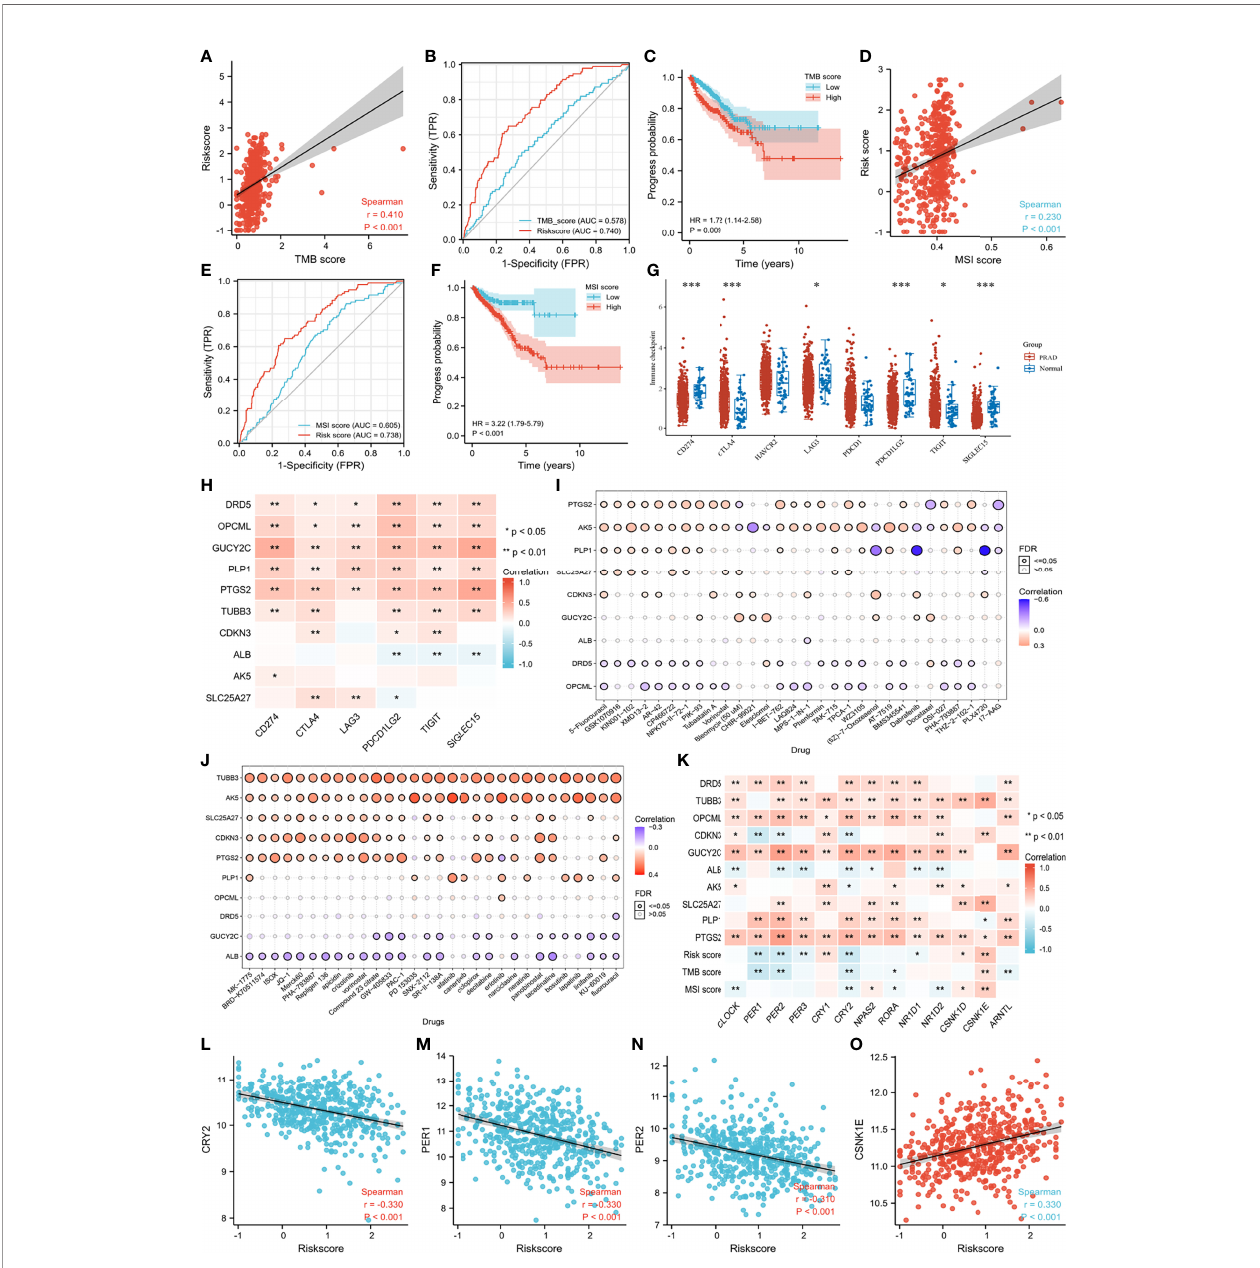
FIGURE 8 | Immune related scores, drug sensitivity and correlation regarding genes of circadian clock pathway. (A) the correlation between TMB score and risk score; (B) the receiver operating characteristic curves of TMB score and risk score; (C) the progress difference of high TMB group and low TMB group; (D) the correlation between MSI score and risk score; (E) the receiver operating characteristic curves of MSI score and risk score; (F) the progress difference of high MSI group and low MSI group; (G) the immune checkpoint difference between PCA and normal samples; (H) the correlation between enrolled genes and immune checkpoint genes; (I) the correlation between gene expression and the sensitivity of GDSC drugs (top 30) in pan-cancer; (J) the correlation between gene expression and the sensitivity of CTRP drugs (top 30) in pan-cancer; (K) the correlation between genes of circadian clock pathway and enrolled genes and immune scores; (L) the correlation between CRY2 and risk score; (M) the correlation between PER1 and risk score; (N) the correlation between PER2 and risk score; (O) the correlation between CSNK1E and risk score. ***means smaller than